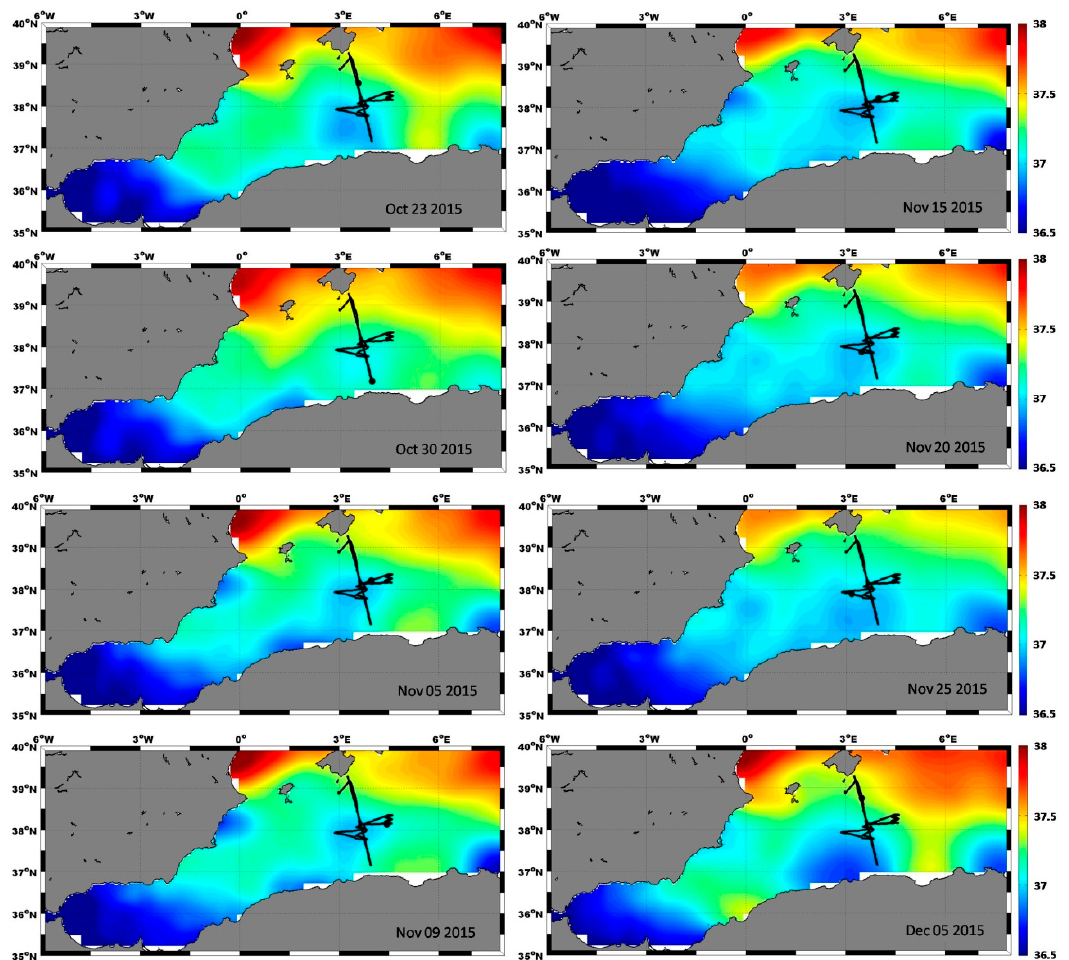
Figure 14. SMOS L4 SSS maps of the Alboran Sea and the Algerian Basin on eight representative dates of the ABACUS 2 survey. Glider track in black.